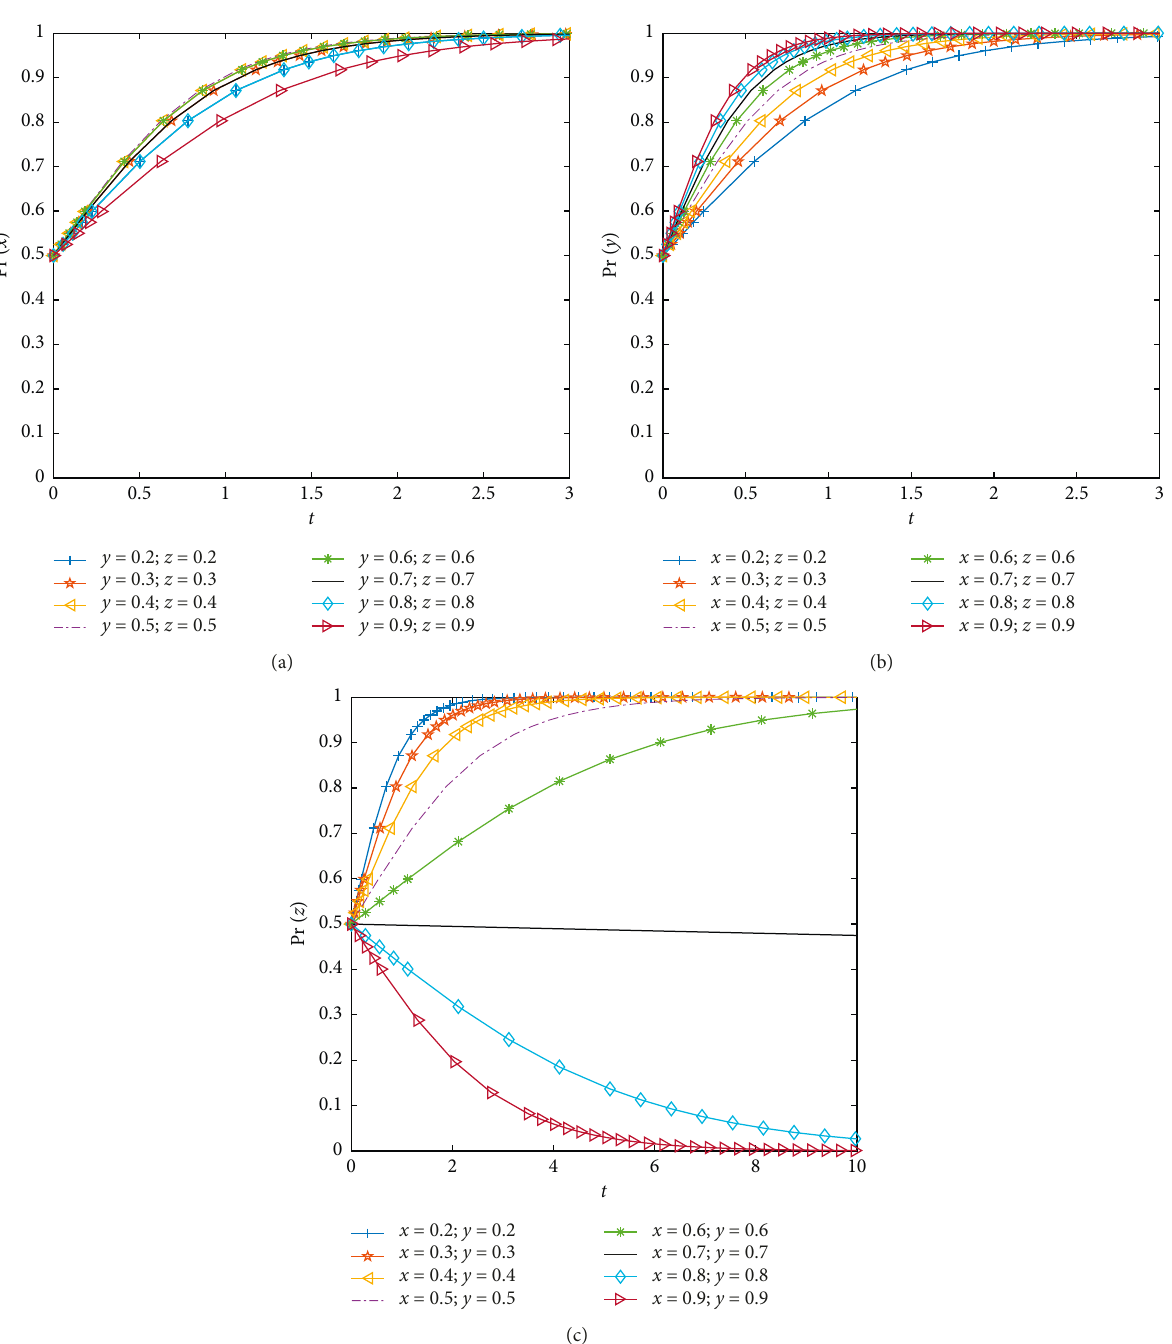
Figure 2: (a) Evolution curve of x when y and z change. (b) Evolution curve of y when x and z change. (c) Evolution curve of z when x and y